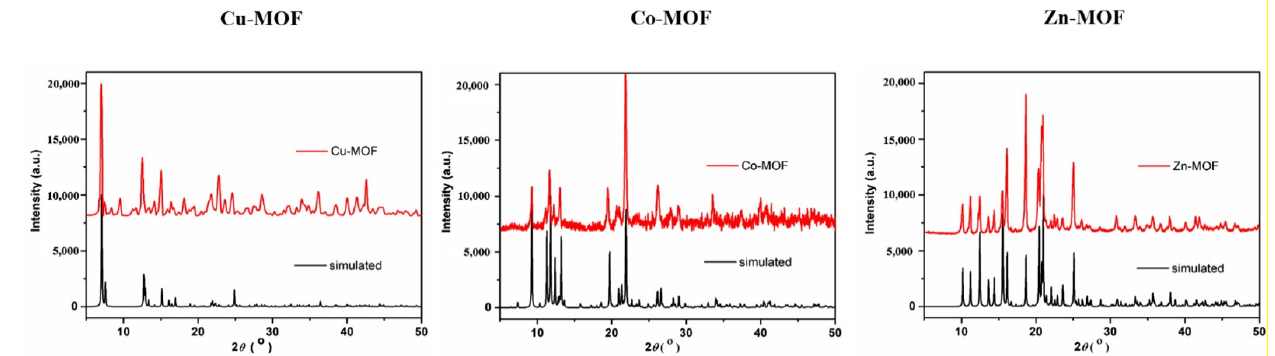
Figure 2. PXRD patterns of the Cu-MOF, Co-MOF, and Zn-MOF: simulated ( black ) and as-prepared ( red ).